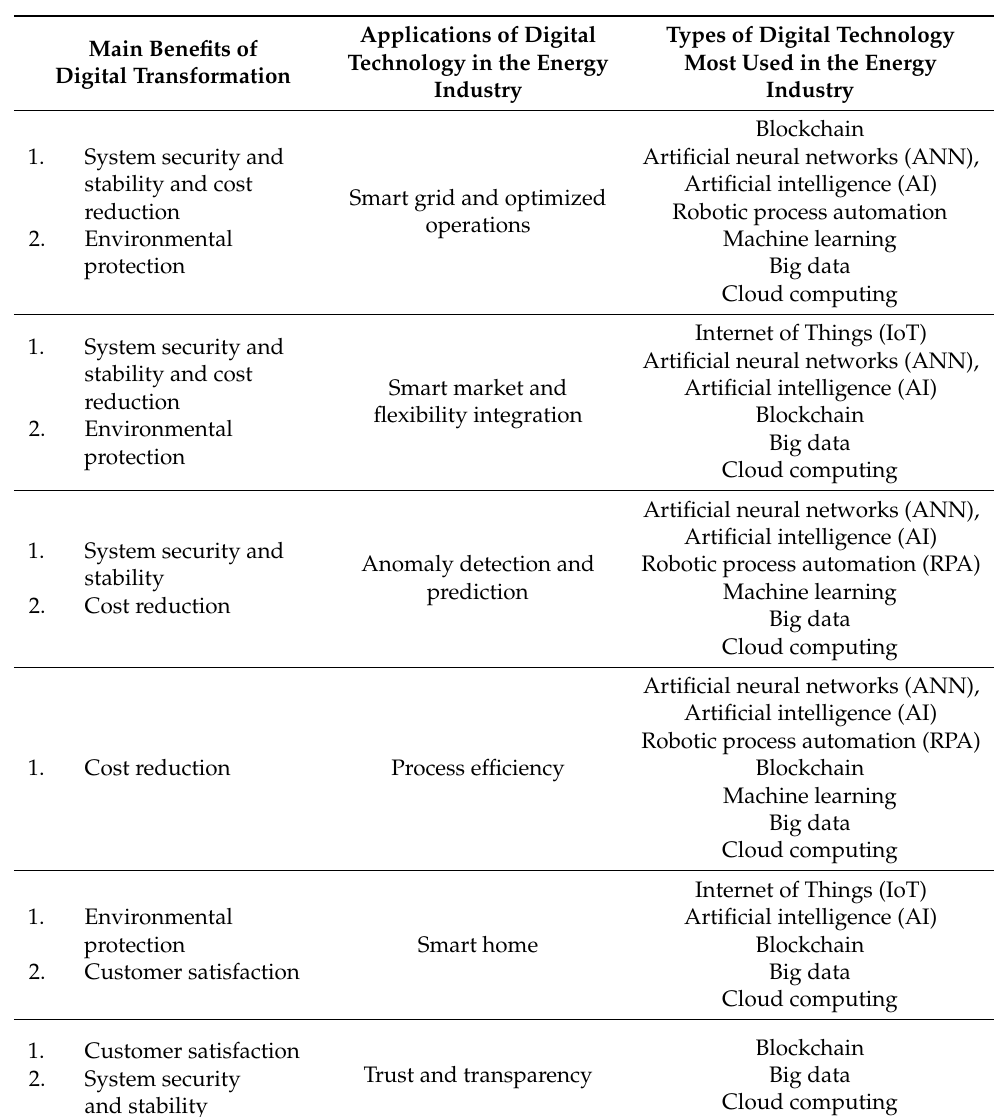
Table 1. Digital applications and their use and benefits in the energy